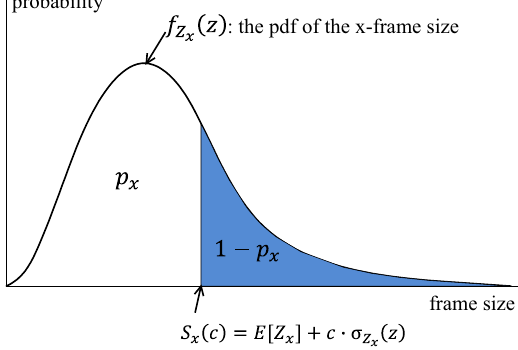
Figure 4. Schematic illustration of p x and S x ( c )